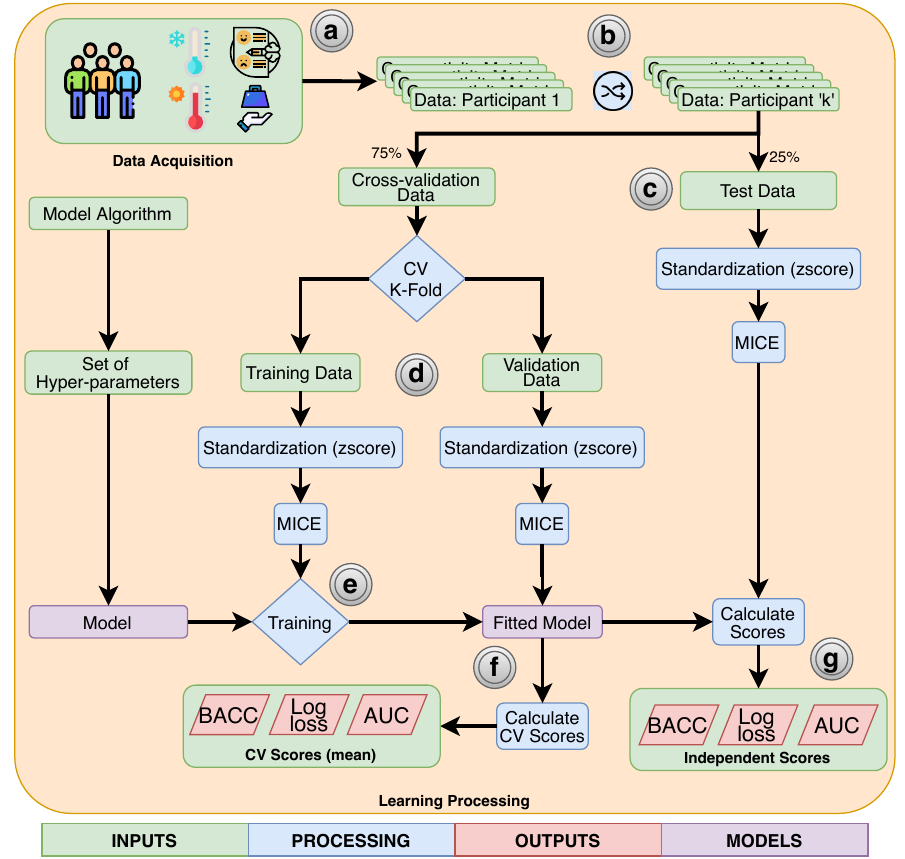
Figure 1. Flowchart describing the entire process of acquisition, preprocessing, processing, learning, and evaluation. ( a ) Participants answered the questionnaires and were evaluated using the sensorial tests of cold, heat, and pressure. ( b ) The learning process started shuffling the list of subjects’ data. ( c ) An independent test was selected to be used to compare the best-fitted models after hyper-parameter optimization; this set represents 25% of the total dataset and preserves the proportion of target classes. With the remaining 75%, we applied a five-fold cross-validation process to optimize the hyper-parameters ( d ). The cross-validation applied two equal pipelines for the training and validation data. These pipelines sequentially apply a standardization method, an imputation method (multiple imputation by chained equation (MICE)), and the model in a training context ( e ) or the fitted model in order to obtain the cross-validation scores ( f ). Finally, ( g ) the fitted model is evaluated using the independent test and the same pipeline used during the